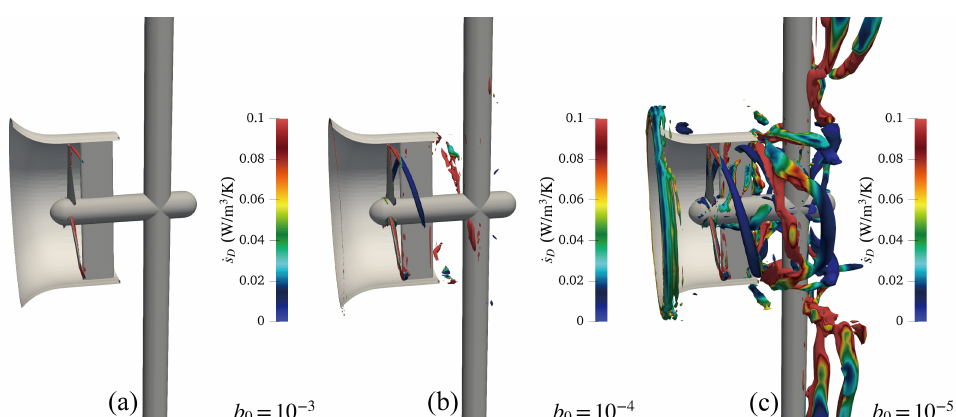
Figure 12. Vortical structure of the turbine, isosurfaced by Ω R = 0.52 with different b 0 ( TSR = 3.6 )